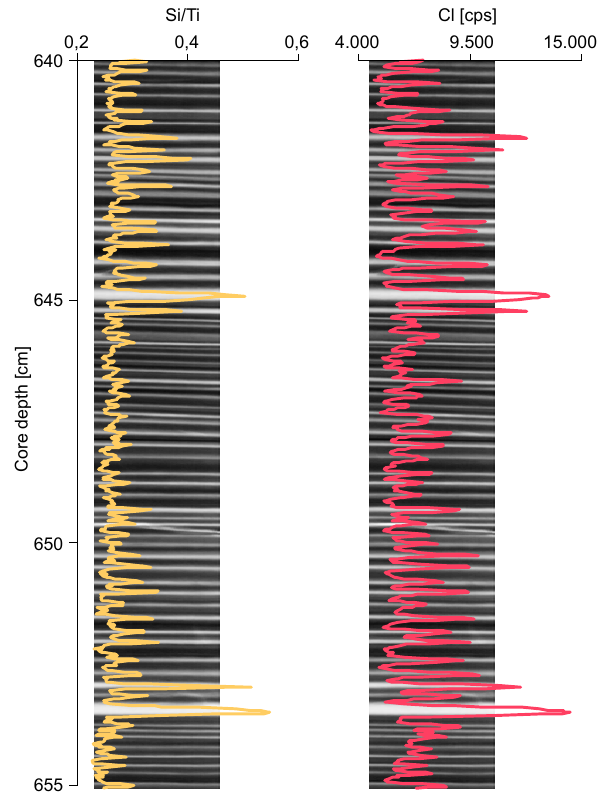
Figure 7. Example micro-XRF Si/Ti and Cl counts and X-ray images of SO202-18-3, 640–655cm core depth. Note that less dense laminae are shown in white. The white laminae with high amounts of well-preserved diatoms represent the spring/summer bloom, while the dark, denser laminae contain high amounts of ter- rigenous